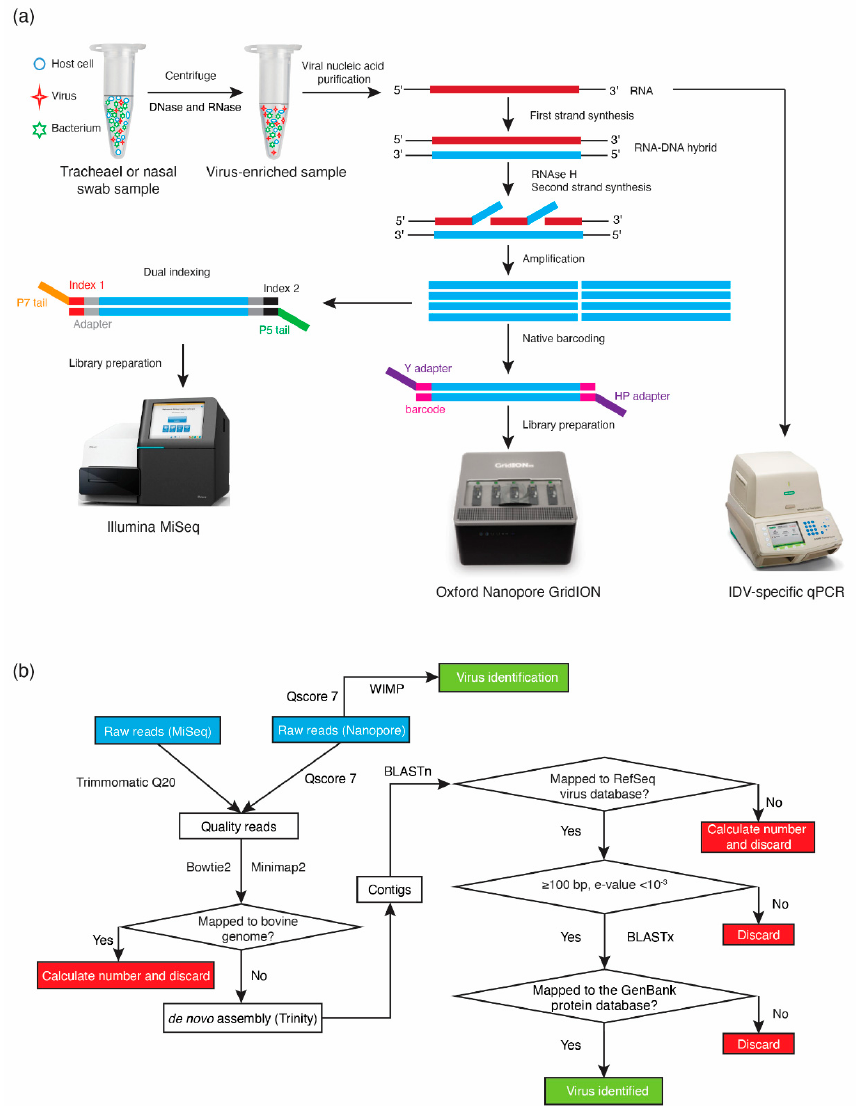
Figure 1. Workflow for GridION Nanopore sequencing, MiSeq sequencing, and qPCR of bovine respiratory tract samples (BRD). ( a ) The workflow illustrates both the sample and library preparation.